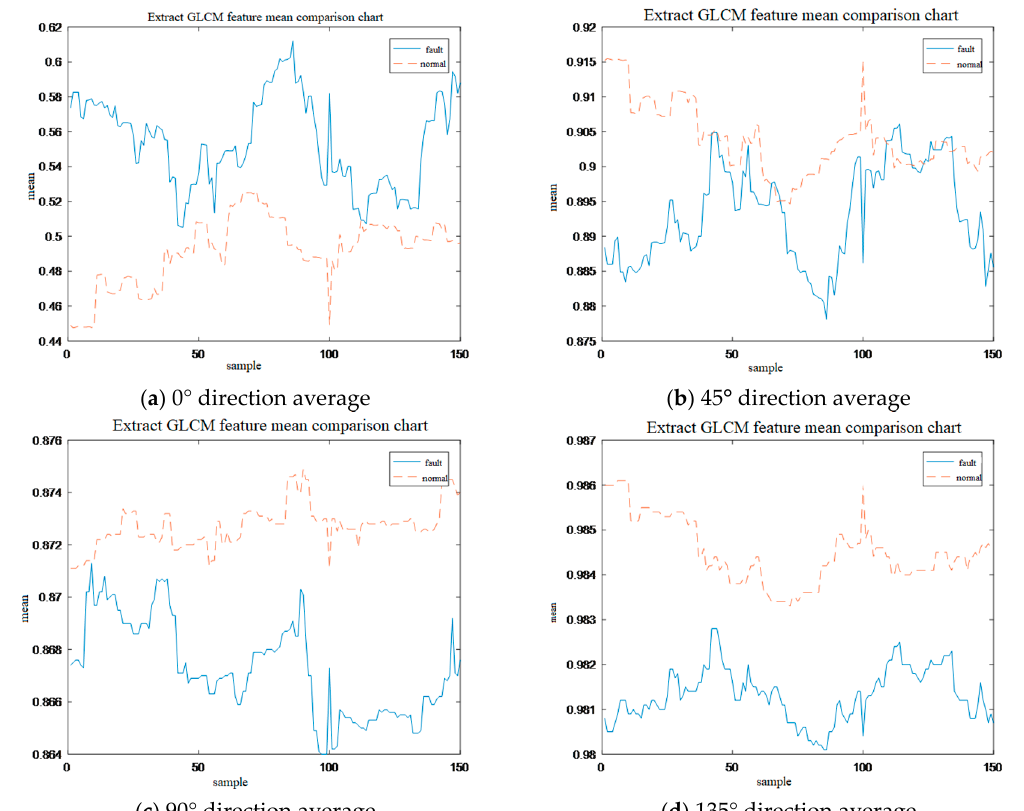
Figure 5. GLCM feature average value comparison.